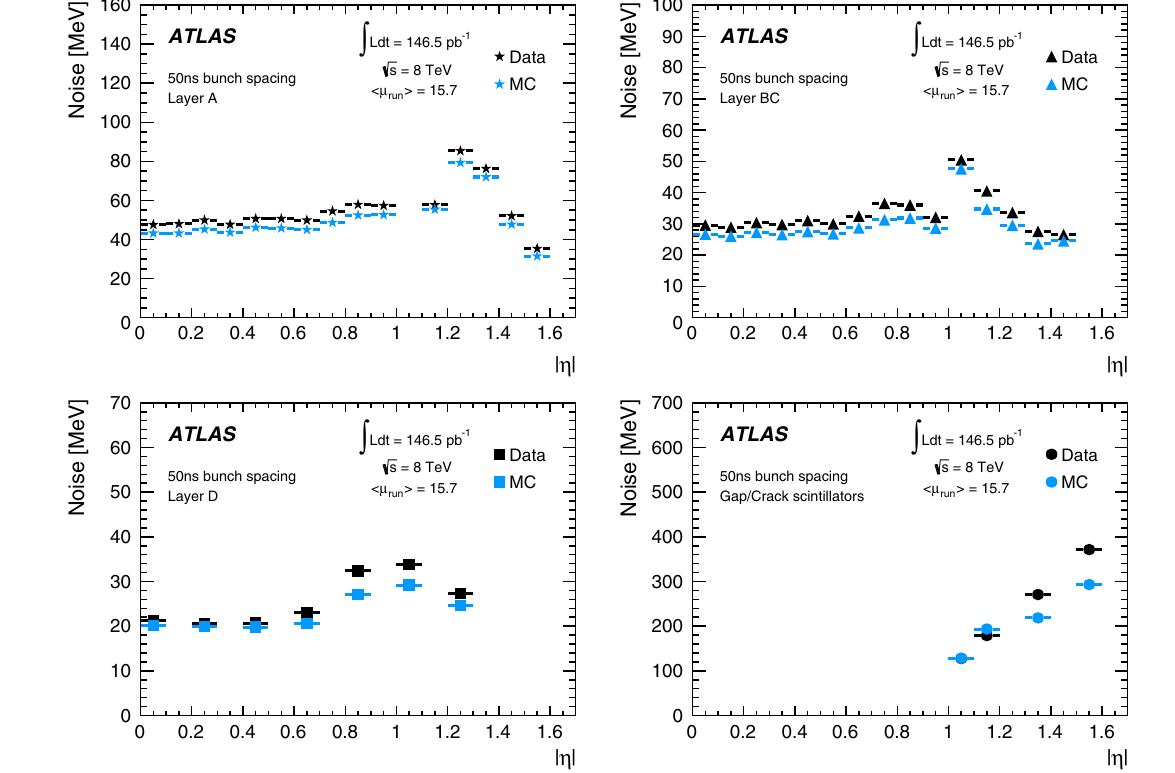
shown in blue. Four layers are displayed: layer A (top left), layer BC (top right), layer D (bottom left), and the special gap and crack cells (bottom right). The electronic noise component is shown in Fig. 8